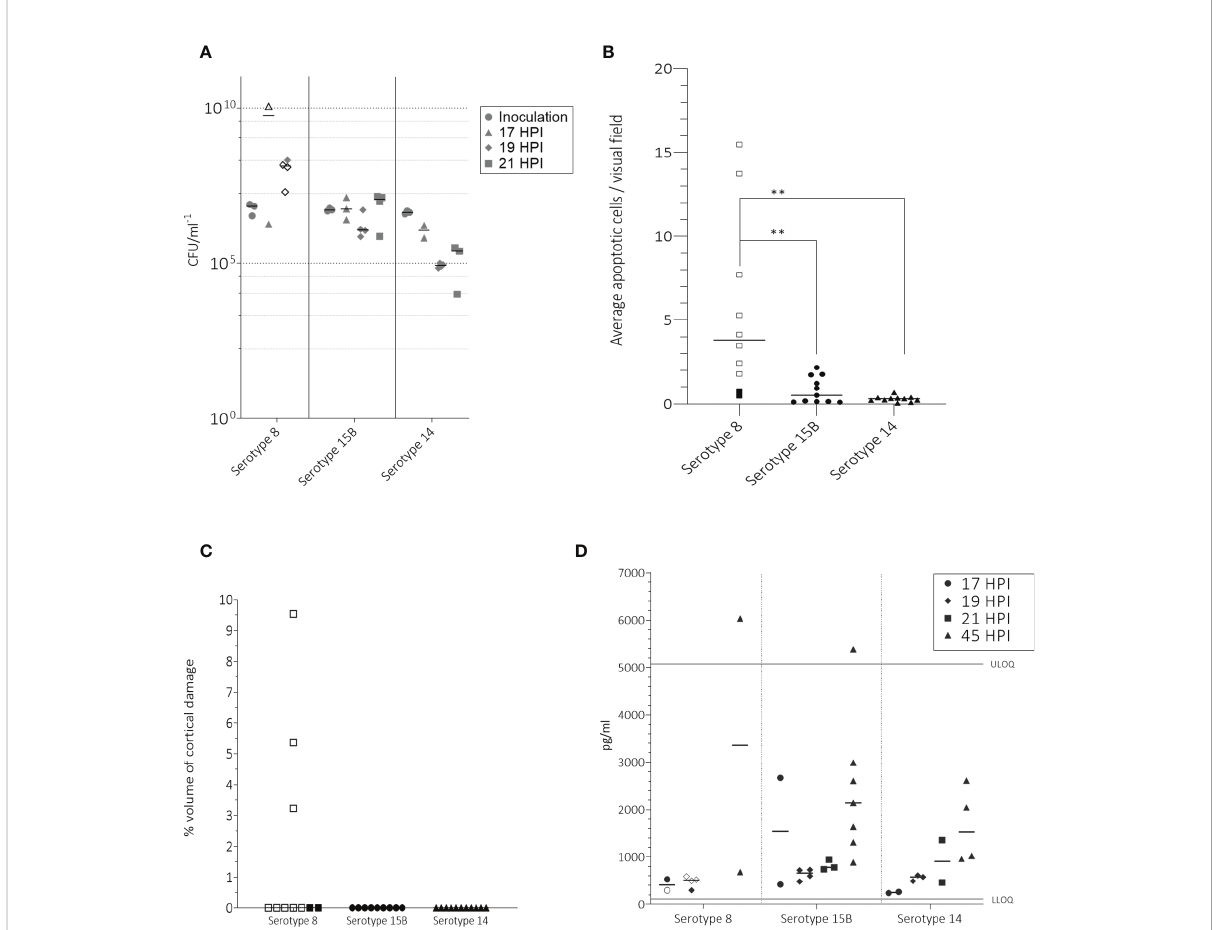
FIGURE 2 In the infant rat model following intracisternal administration of 1 – 5 x 10 6 CFU/ml S. pneumoniae of serotypes 8, 15B or 14, bacterial titers at inoculation, 17, 19 and 21 hpi in the CSF (A) , number of apoptotic cells counted in the hippocampus (B) , volume of cortical injury (C) and neuro fi laments (NfL) in the CSF at 45 hours post infection (hpi) (D) . (A) For inoculum, one point represents the average CFU/ml at the beginning of one experiment. At 45 hpi, after treatment with ceftriaxone no bacteria were detected. Animals infected with serotype 8 had signi fi cantly higher bacterial titres at 19 hpi than those infected with serotype 14 (p-value = 0.0051) (B) Animals infected with serotype 8 had signi fi cantly more (p-value < 0.05) apoptotic cells than those infected with either serotype 15B or 14. (C) Only animals infected with serotype 8